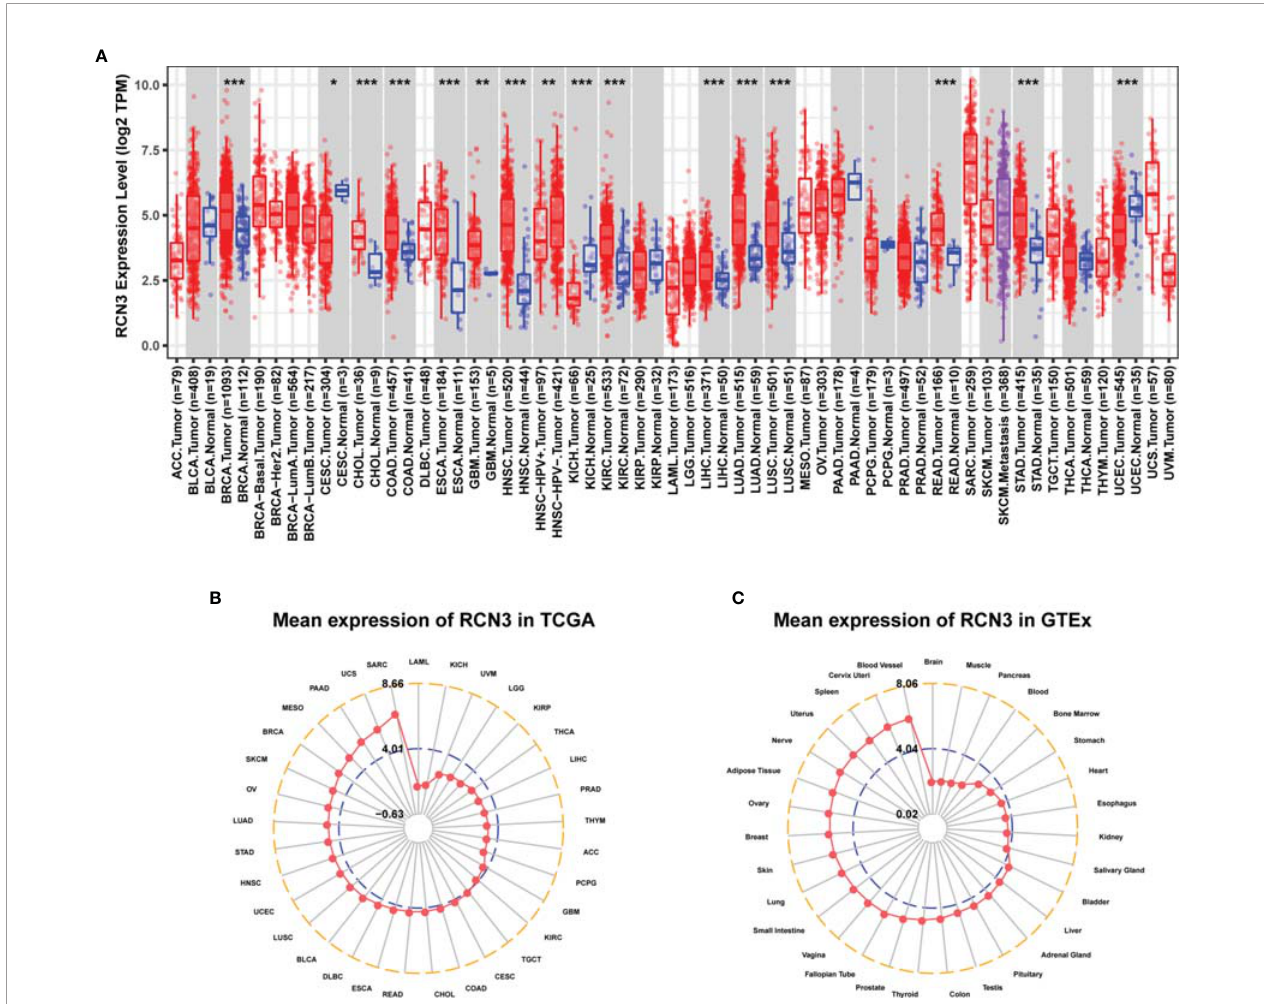
FIGURE 1 | RCN3 expression levels in different human cancers. (A) The expression level of RCN3 in different tumor tissues and normal tissues was analyzed through TIMER2 database (*P < .05, **P < .01, ***P < .001). The radar charts (ggradar package was used for analysis) showing the expression of RCN3 in different cancers from TCGA (B) and in normal tissues of the GTEx (C) . Mean expression was the basis of